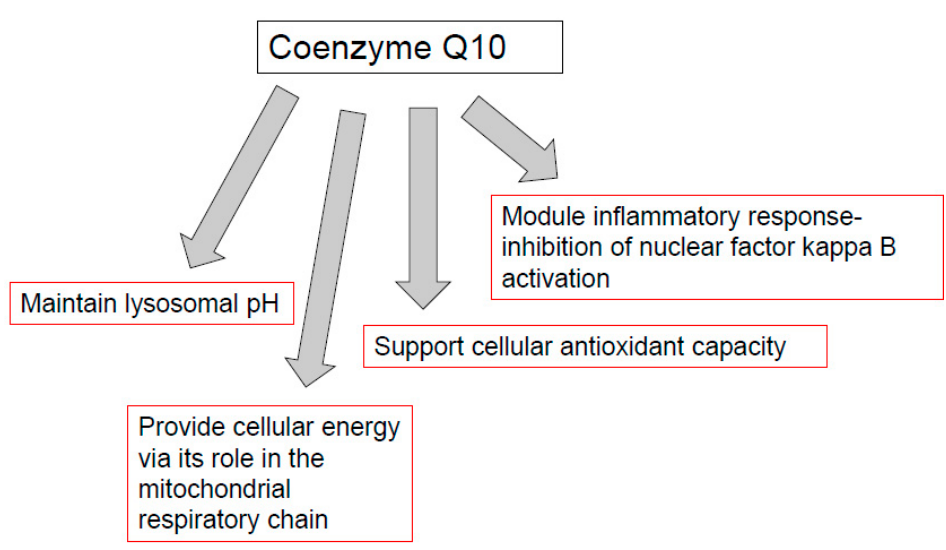
Figure 2. Functions of coenzyme Q10 supplementation in immunopathy, ageing, cancer, and immune function in athletes. TLR-4: toll-like receptor 4 (TLR-4). NFkB: nuclear factor kappa B; AP-1: Activator protein-1. PGC-1 alpha: peroxisome proliferator-activated receptor coactivator 1 alpha. Nuclear factor erythroid 2-related factor